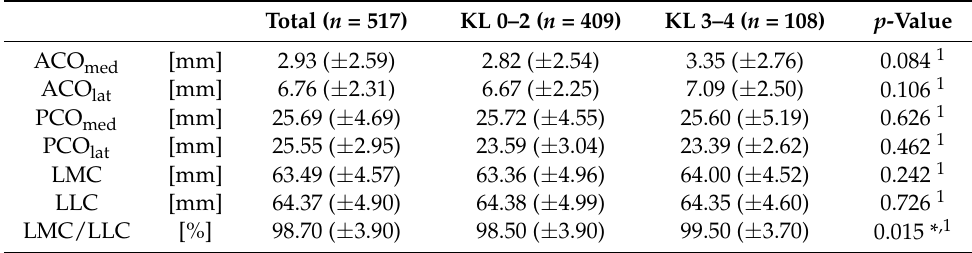
Table 6. Analysis of osteoarthritis-specific differences for femoral condylar parameters between patients without ( n = 409) and with osteoarthritis ( n = 108). Total ( n =